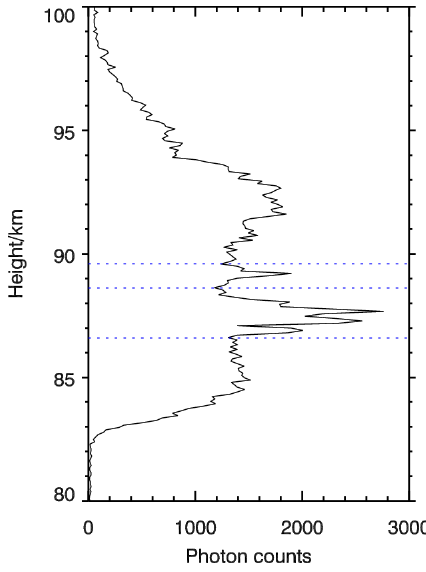
Fig. 10. The raw profile of a Na s layer with the integration time of